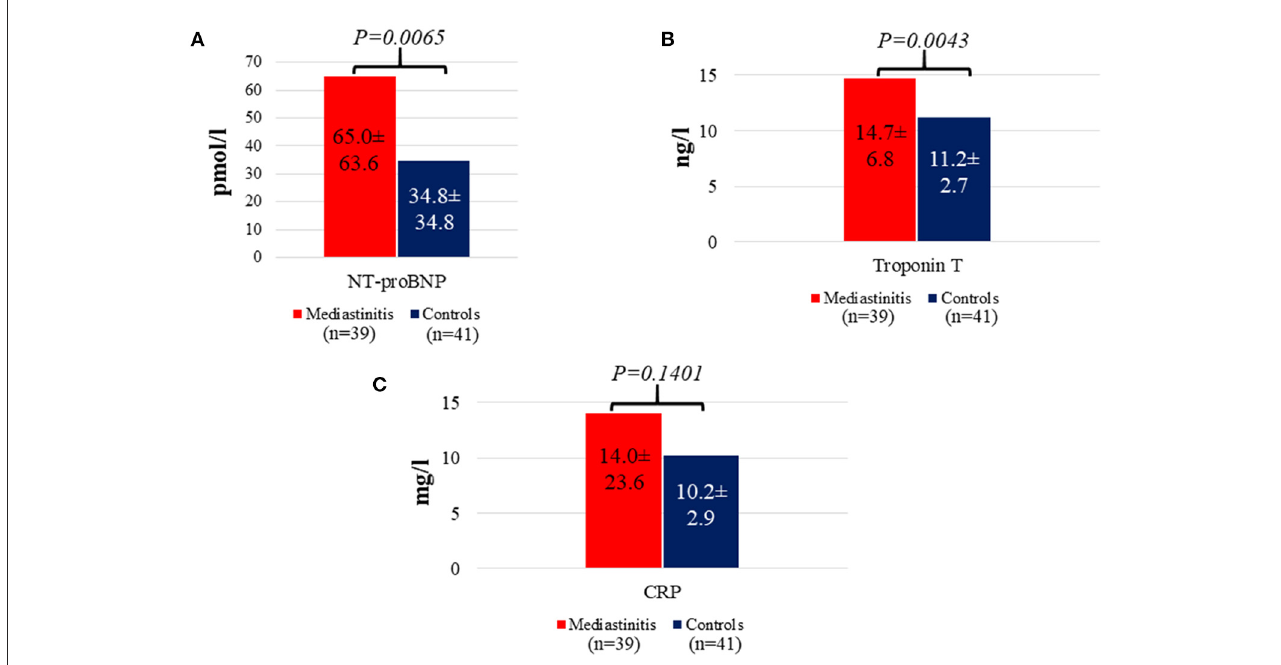
FIGURE2 Distribution of NT-proBNP (A) , Troponin T (B) , and CRP concentrations (C) in patients with mediastinitis versus controls. Date are presented here as mean ±